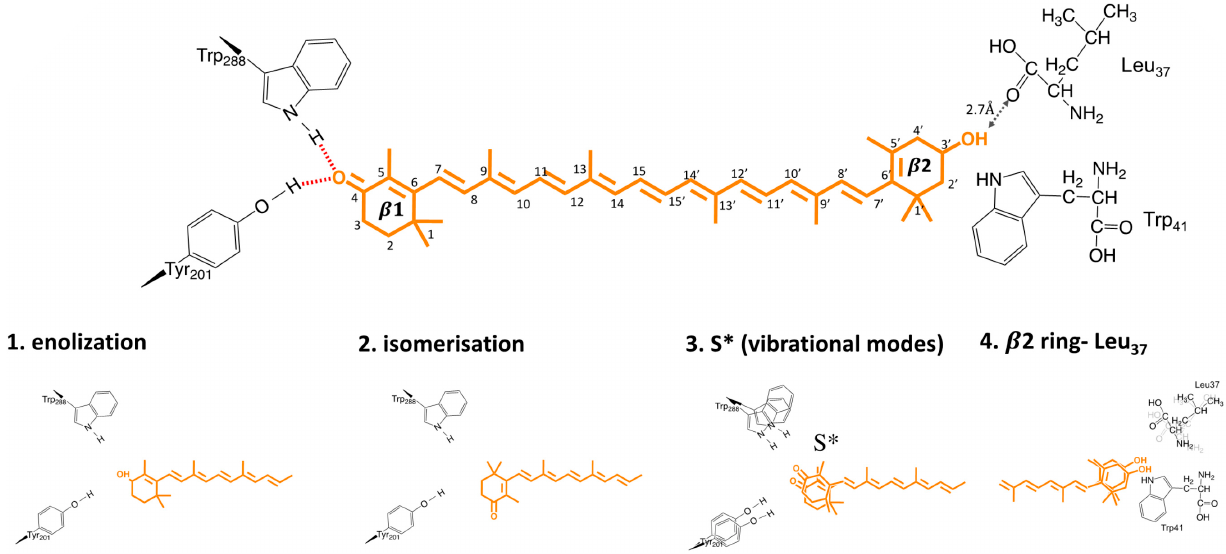
Figure 7. Possible triggers for OCP photosensing (see Section 6 for details).